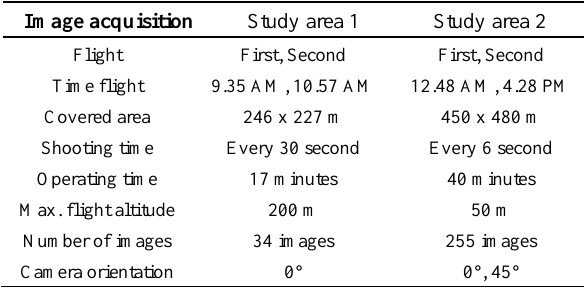
Table 2. Flight and mission planning of this experiment